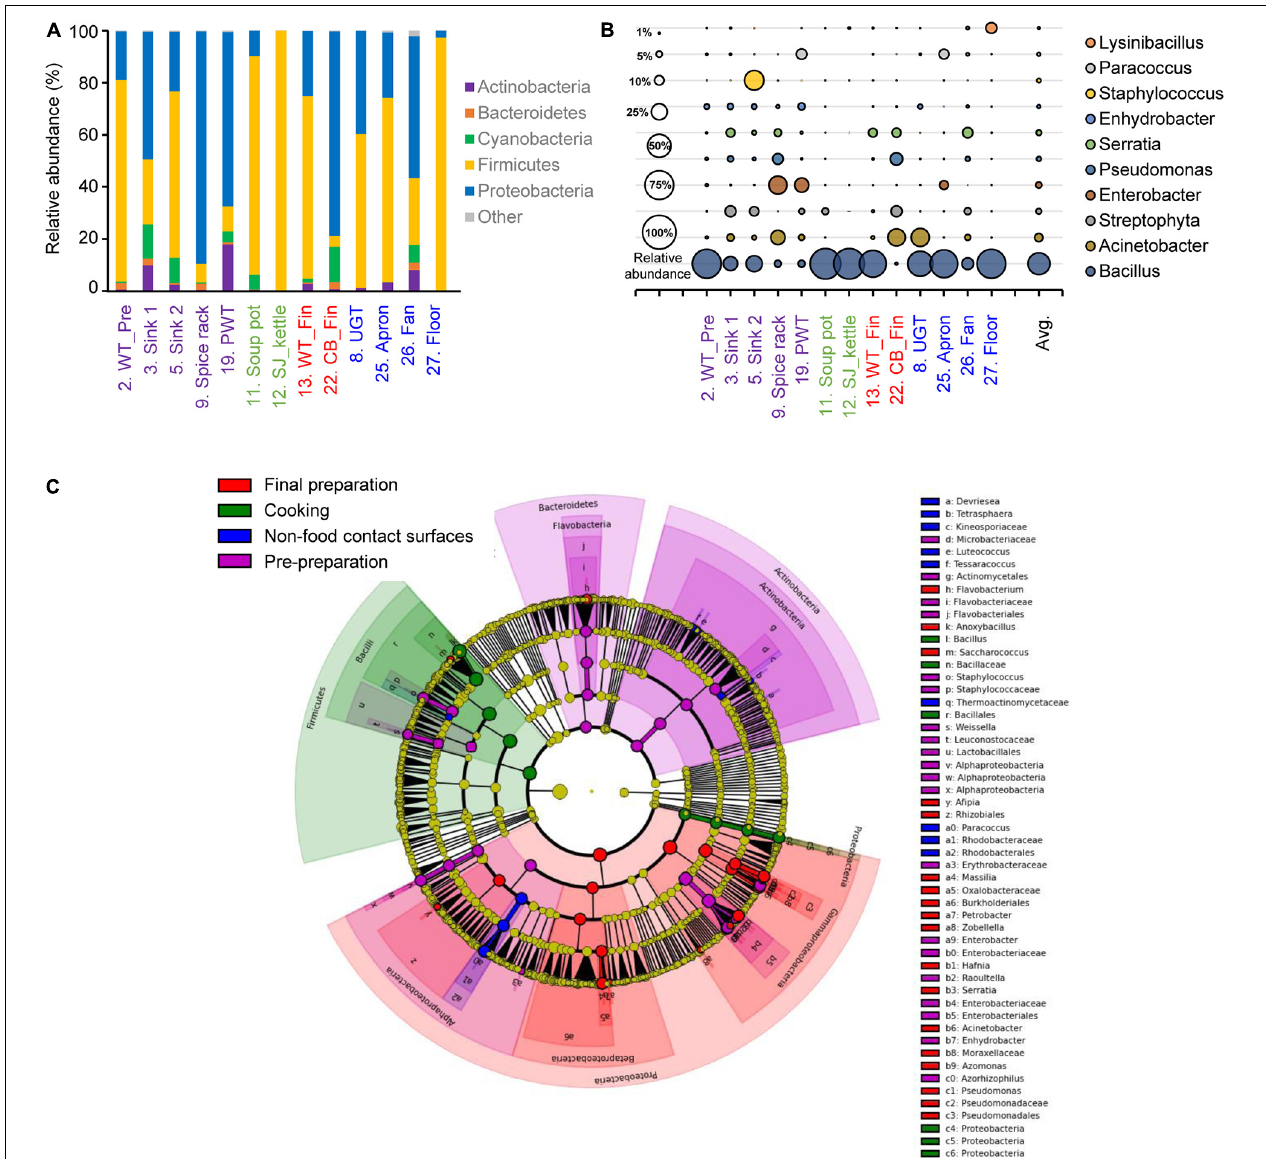
FIGURE 2 | Comparison of the bacterial distribution in each food-contact and non-food contact surfaces. Relative abundances at phylum level (A) and genus level (B) , and the LEfSe cladogram (C) of taxonomic LDA score higher than 3.0. The pre-preparation area, cooking area, final preparation area, and the cooking environment indicated as purple, green, red, and blue,